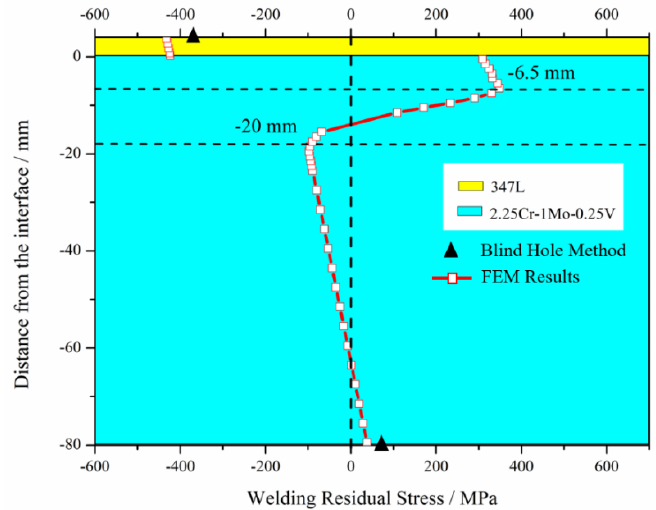
Figure 10. Final WRS distribution of elastic–plastic model and comparison with blind hole method.